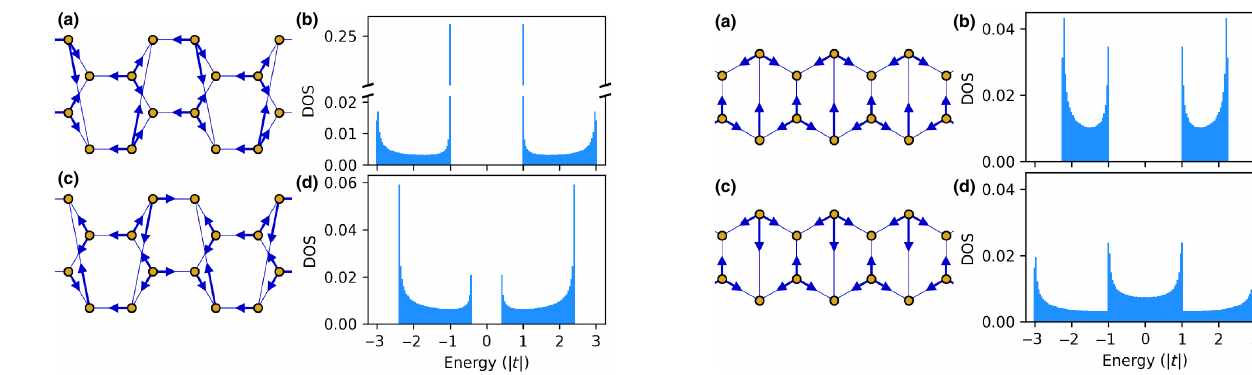
FIG. 9. n = 1, m = 1 nanotube. This nanotube, or ladder, is an example of a graph where the exact ground-state orientation is known. The true ground-state orientation and the corresponding DOS are shown in (a),(b). This orientation has an extremely large = 2. By contrast, the sector-energy gap single-particle gap: 2 λ (τ) 1 is bounded above by approximately 0.068 per particle. The cor- responding plots for the elementary orientation are shown in c and d and exhibit no single-particle